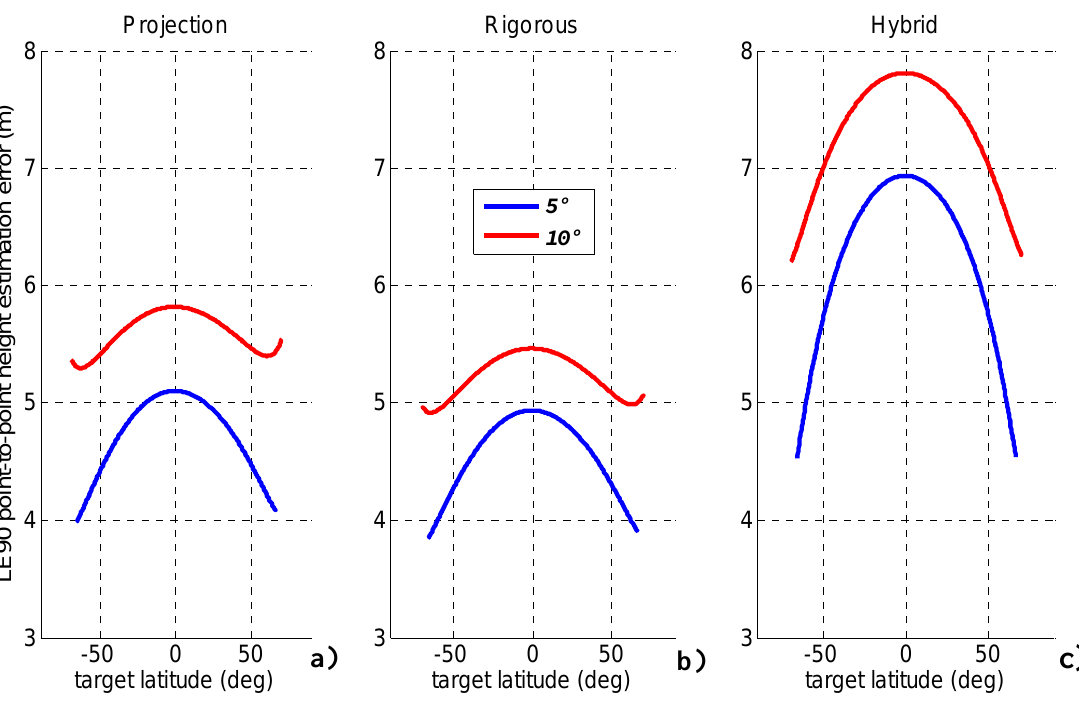
Figure 13. Performance comparison between the analyzed methods for spaceborne bistatic SAR stereo radargrammetry considering 1/2 of an image pixel as co-registration uncertainty and low bistatic off-nadir angles: (a) projection of bistatic parameters, (b) bistatic rigorous stereo SAR problem, (c) hybrid